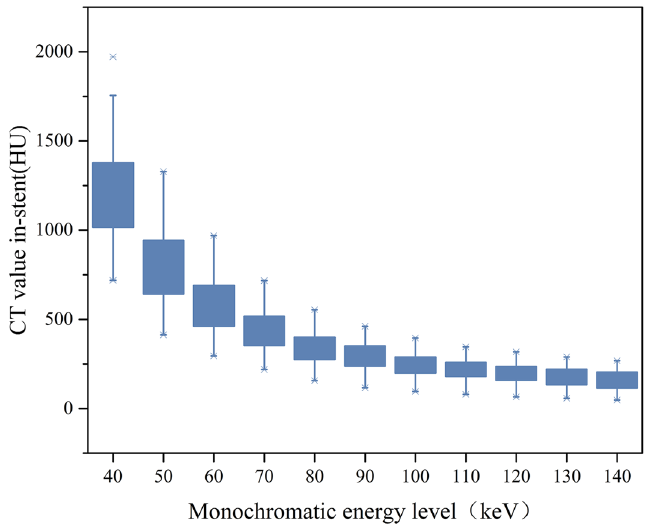
Figure 2. Comparison of CT value in-stent at monochromatic energy levels between 40 and 140 keV in 10-keV increments.